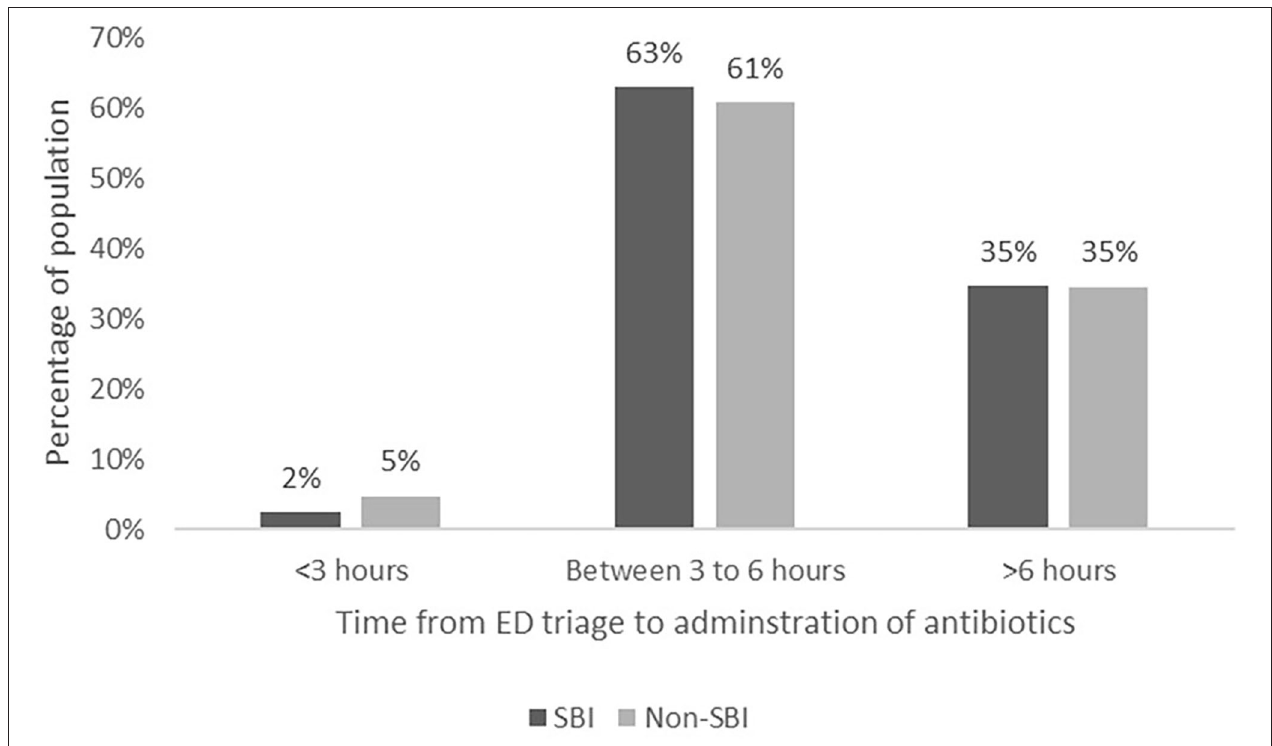
FIGURE 2 | Proportion of infants who received early versus late antibiotics